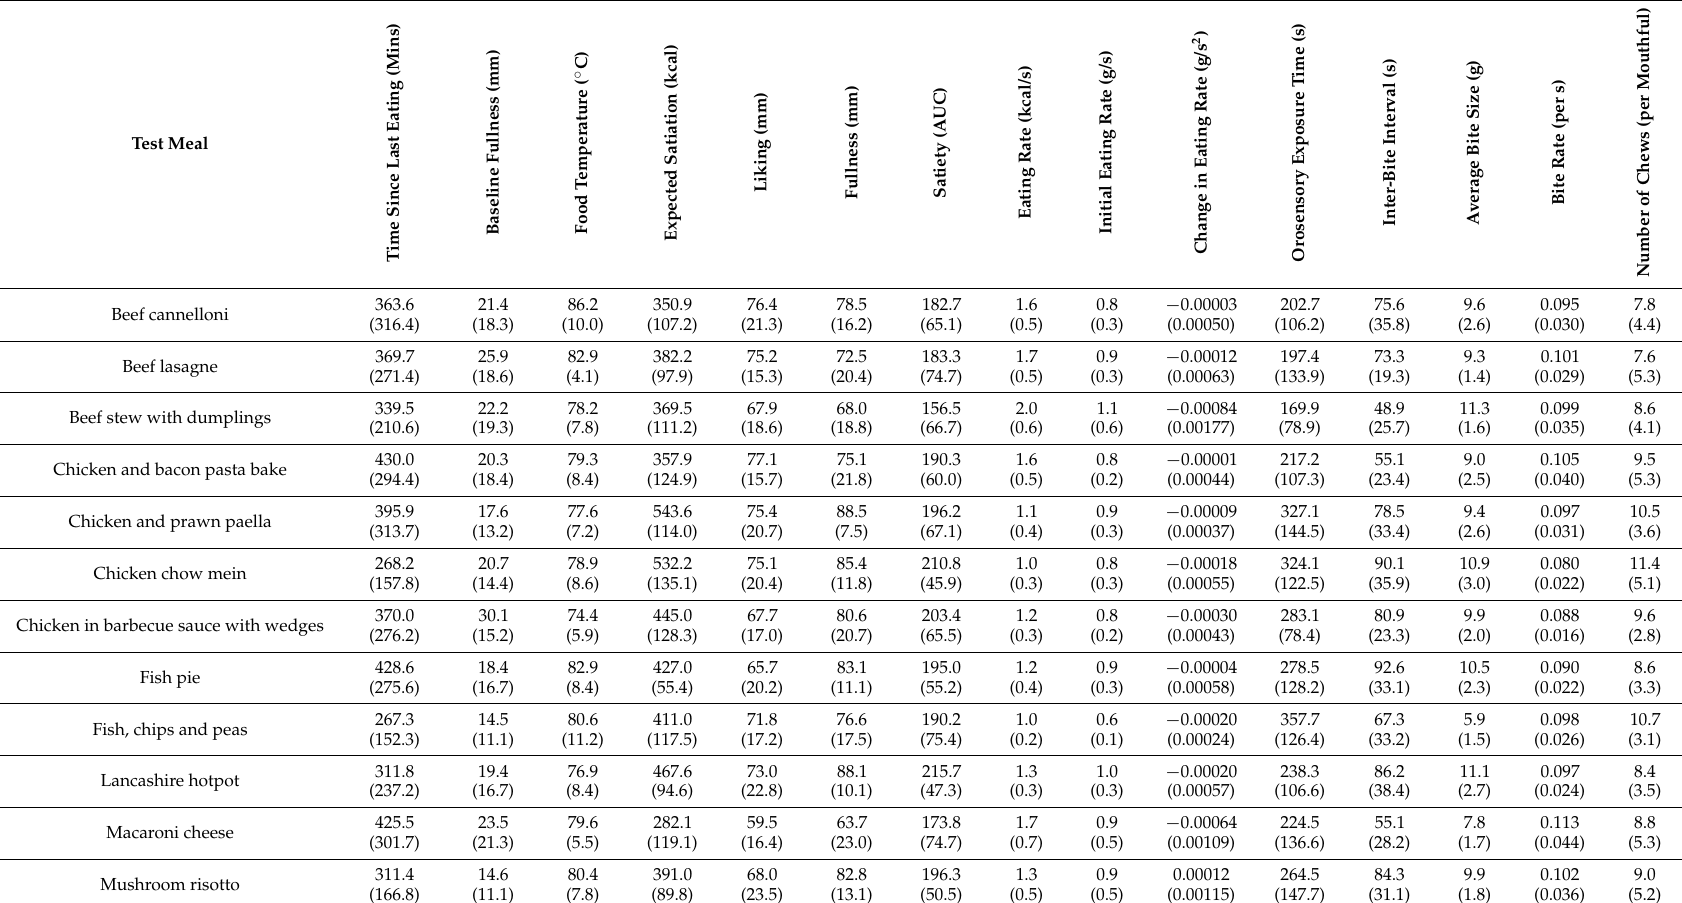
Table 2. Mean ( ˘ S.D.) scores of time since last eating (mins), baseline fullness (mm), food temperature ( ˝ C), expected satiation (kcal), liking (mm), fullness after eating a fixed portion (mm), satiety (fullness area under the curve (AUC)) and oral processing behaviours across the 20 test